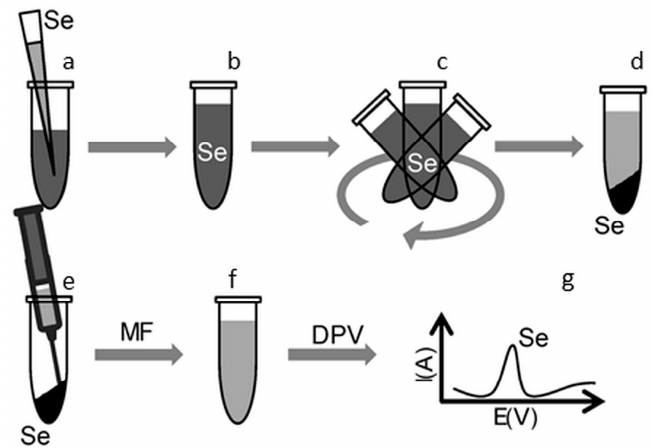
Figure 1. The scheme of selenium removal from aqueous solution using different types of adsorbents: ( a ) Adding Se(IV) to a carbon based adsorbent; ( b ) mixture of adsorbent and standard solution of sodium selenite; ( c ) shaking and mixing of the sample; ( d ) centrifugation; ( e ) removal of supernatant; ( f ) filtration using membrane filter (MF) 0.45 µ m; and ( g ) electrochemical determination of Se(IV) by differential pulse cathodic stripping voltammetry (DPCSV).